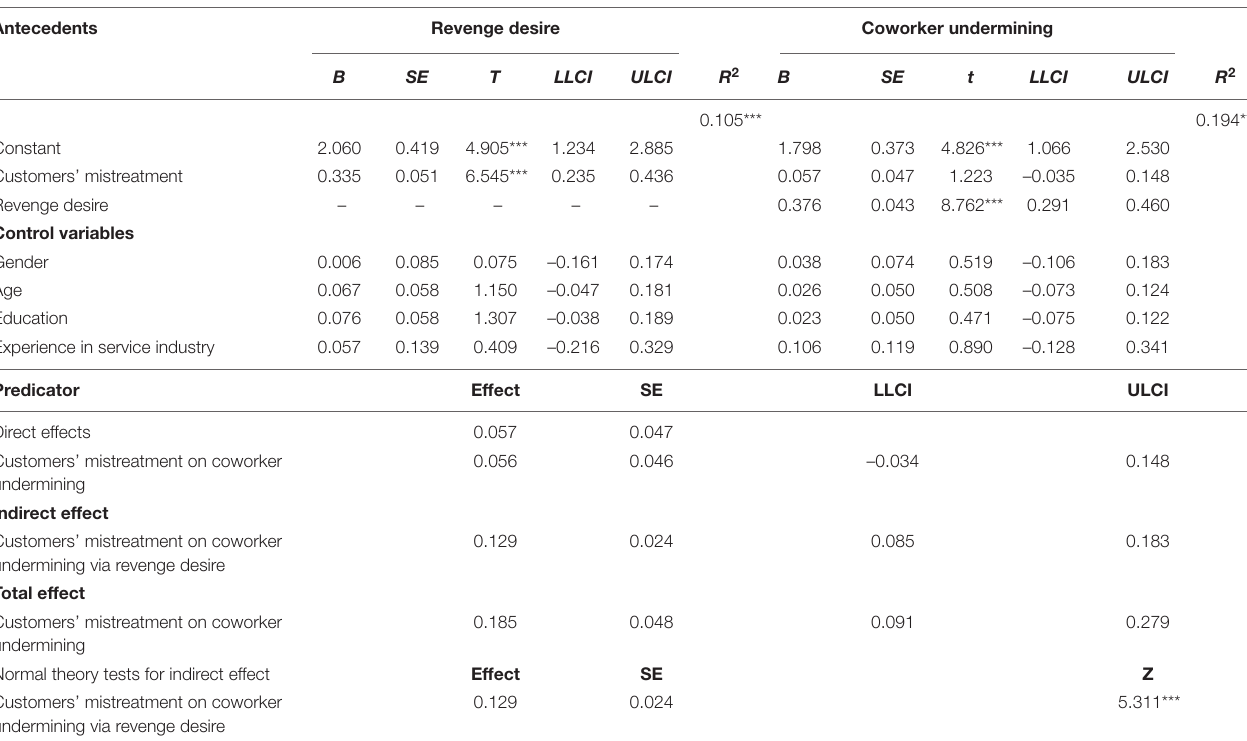
TABLE 2 | Results of mediation analysis.